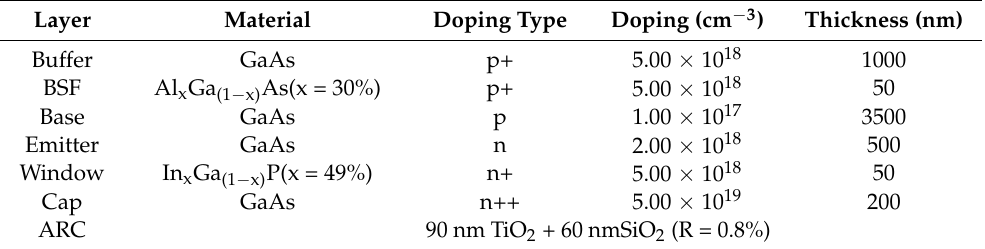
Table 2. The thickness and doping of laser photovoltaics. Figure 7. The simulated structure of laser photovoltaics.